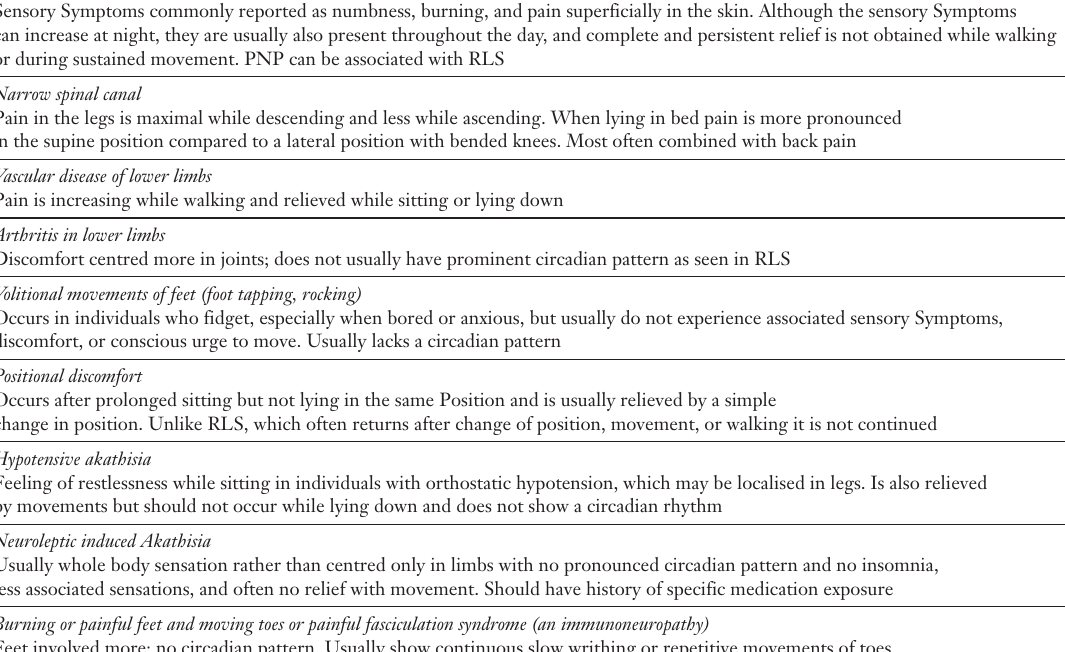
Differential diagnosis (extended after